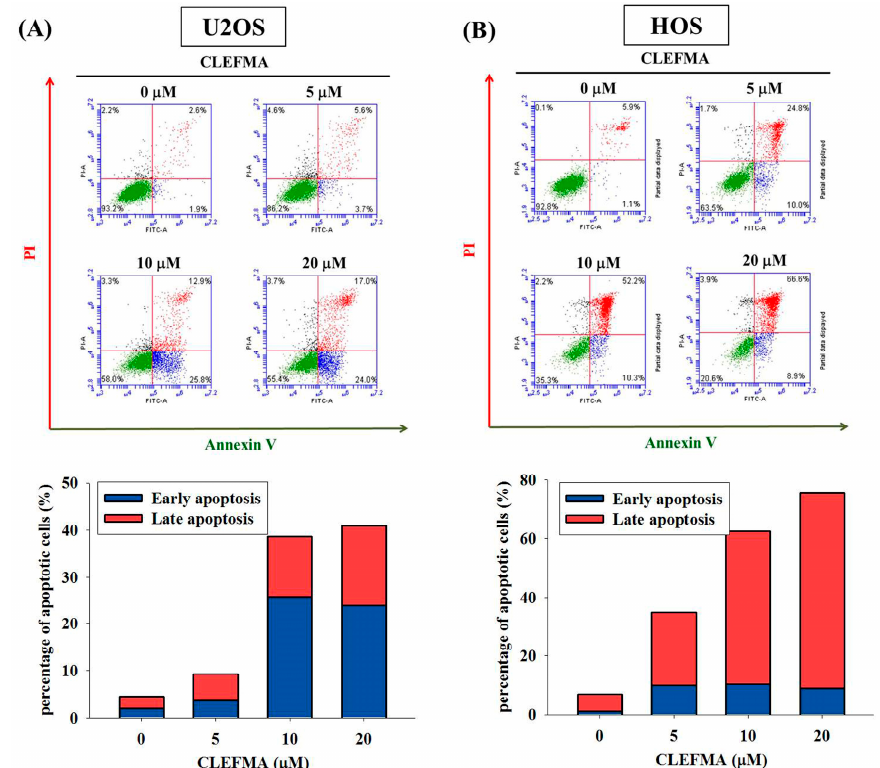
Figure 2. Effects of CLEFMA on the apoptosis of U2OS and HOS cells. ( A ) U2OS and ( B ) HOS cells were treated with CLEFMA (5, 10 and 20 μ M) for 24 h and then subjected to flow cytometry after annexin V-FITC/PI staining. Cells that were considered viable were FITC annexin V and PI negative, cells that were in early apoptosis were FITC annexin V positive and PI negative, and cells that were in late apoptosis or already dead were both FITC annexin V and PI positive. Thus, the quantitative analysis of early apoptosis and late apoptosis was summarized to differentiate apoptosis from necrosis.